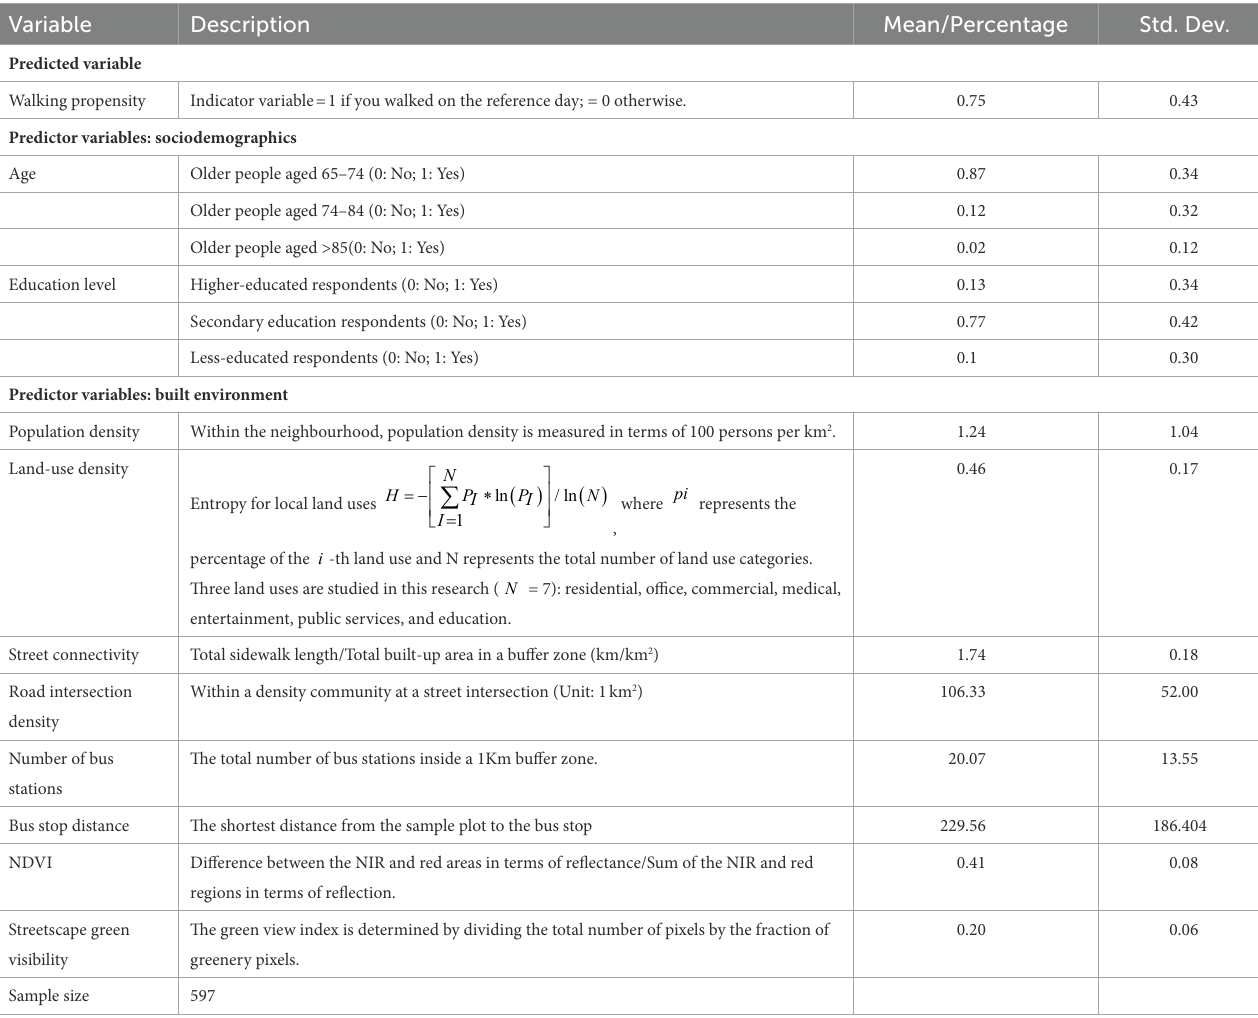
TABLE 2 Summary statistics and descriptions of the predicted and predictor factors. Variable Description Predicted